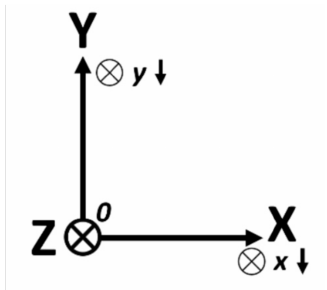
Figure 4. Three axes of the